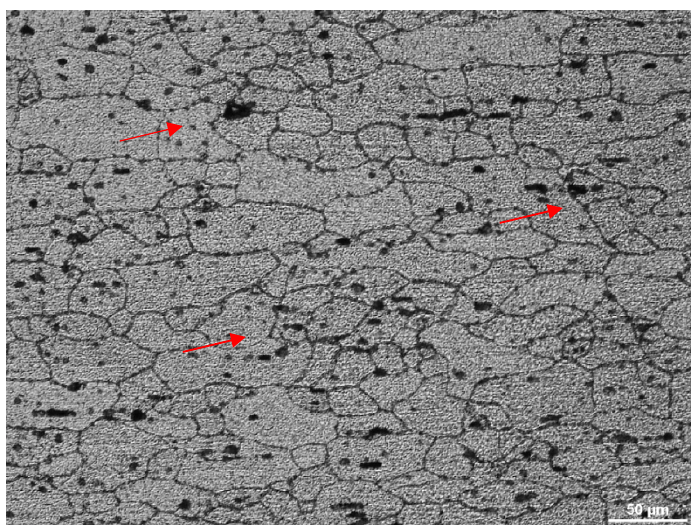
Figure 7. Optical cross-sectional micrograph of wrought Al 6061-T6 samples in as-received condition and etched using Keller’s reagent. There is clear evidence of randomly sized and irregularly distributed second-phase precipitates.